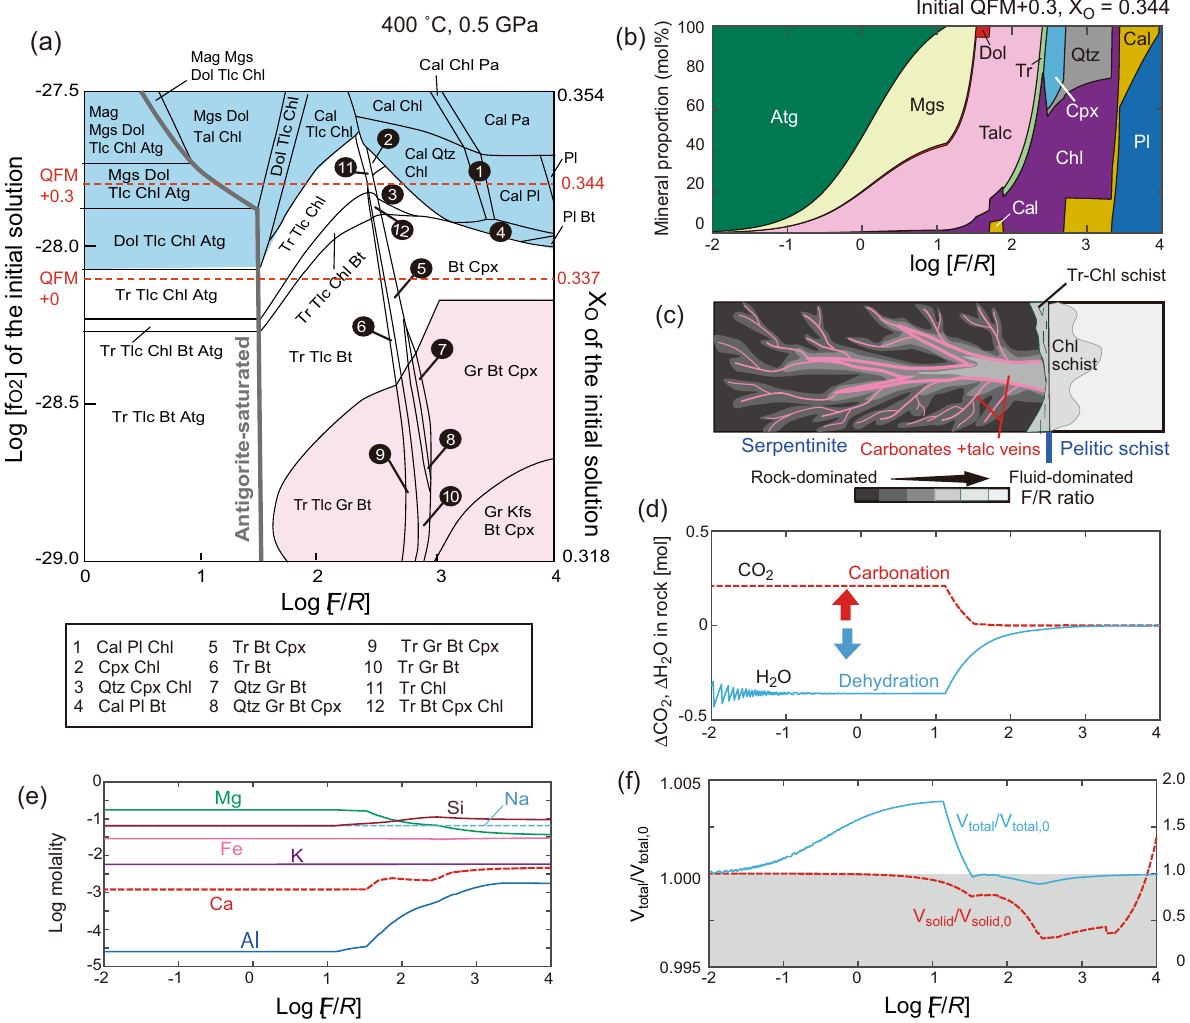
Fig. 4 Results of thermodynamic calculations of the interaction between pelitic-schist-derived fl uids and antigorite at 400 °C and 0.5 GPa. a Stable mineral assemblage as a function of fl uid/rock mass ratio ( F/R ) and oxygen fugacity, f O2 and the atomic fraction of oxygen to oxygen + hydration, X O , of the initial solution. Pale blue and pink shaded regions indicate carbonate- and graphite-bearing assemblages, respectively. Red dashed lines indicate QFM + 0 ( X O = 0.337) and QFM + 0.3 ( X O = 0.344) of the initial solution. b – f Results in the case of log f O2 = – 27.8 (QFM + 0.3, X O = 0.344) of the initial solution as a function of log [ F/R ]. b Mole percent of product minerals. c Schematic illustration showing the relationship between the F/R ratio and mineralogical evolution of the Higuchi serpentinite body. d Change in moles of H 2 O ( 4 H 2 O) and CO 2 ( 4 CO 2 ) in rock before and after reaction. e Total concentration (mol/kg) of individual elements (Si, Al, Fe, Mg, Ca, Na, K) in fl uids. f Solid volume ratio ( V solid / V solid,0 ) and total volume ratio ( V total / V total,0 ) before and after reaction. Kfs K-feldspar, Bt biotite, Cpx clinopyroxene, Tr tremolite, Chl chlorite, Qtz quartz, Cal calcite, Dol dolomite, Mgs magnesite, Gr graphite, Pl plagioclase, Pa paragonite, Mag